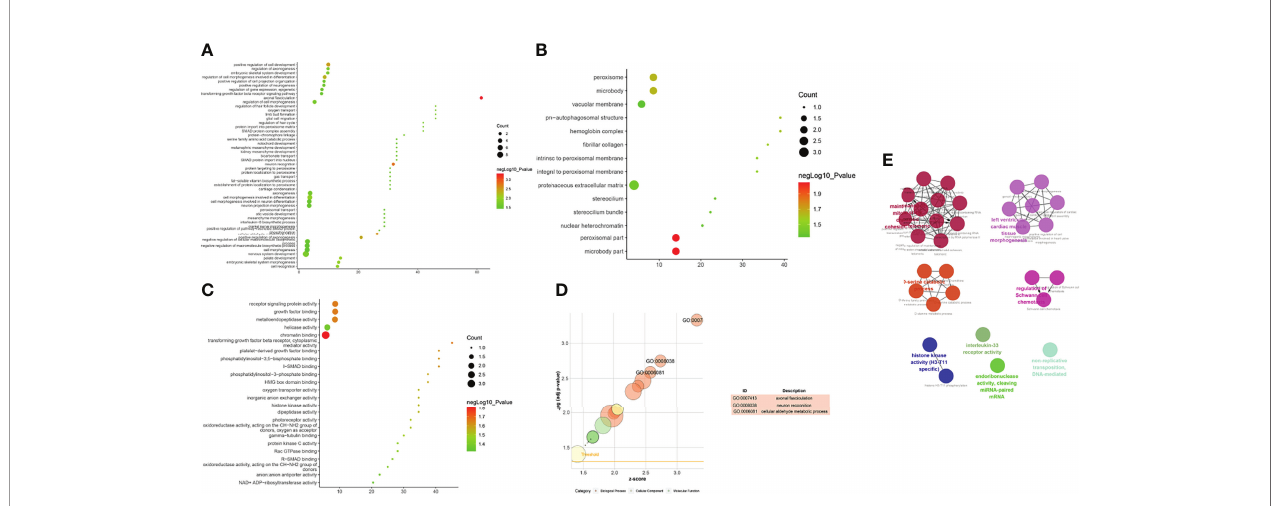
FIGURE 7 | Enrichment Analysis of up-regulated mRNAs [ (A) biological processes; (B) cell components; (C) molecular functions; X-axis stands for fold enrichment. (D) go bubble chart of top GO results; (E) enrichment